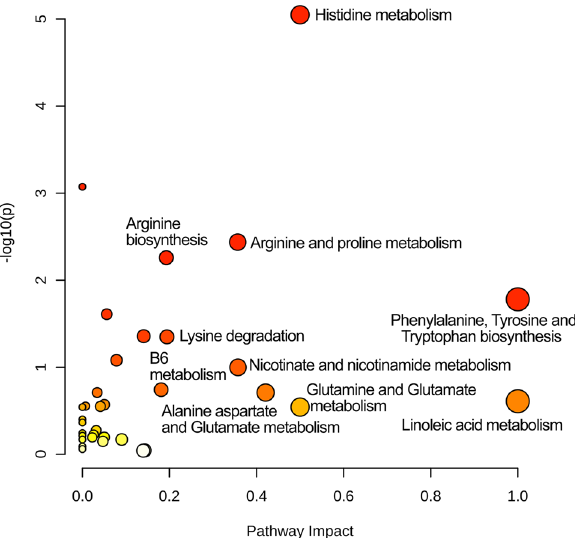
Figure 4. Pathway analysis plot of altered metabolic pathways after acute stress. Dots represent metabolic pathways altered after 24 h of major stress. The Y-axis represents the logarithm transformed P -value adjusted for multiple comparisons. The X-axis represents the pathway impact, calculated by overrepresentation of metabolites from the same pathway, as well as highly important metabolites to the pathway. The pathways that were most associated with stress are a combination of high pathway impact and -log 10 ( Adj P -value) > 1.1220, which is equivalent to a P -value < 0.05 (the top right corner of the graph). Colour represents significance, from White (not significant) to Red (significant), and larger dot size represents a higher impact score. The figure was created by the online tool MetaboAnalyst 5.0 (www. metab oanal yst. ca/ Metab oAnal